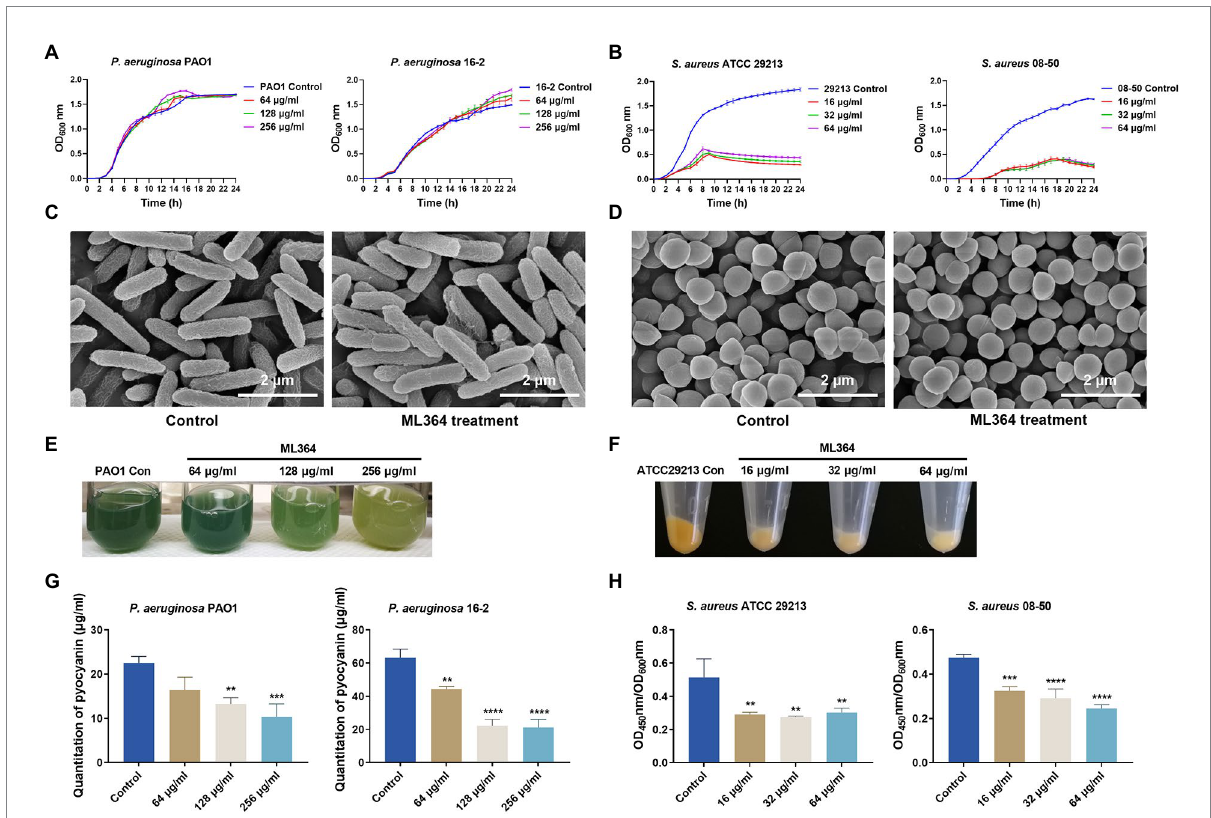
FIGURE 1 The in vitro studies of ML364. (A) Growth curves of Pseudomonas aeruginosa PAO1 and carbapenem-resistant P. aeruginosa (CRPA) 16-2 treated with and without ML364. (B) Growth curves of S. aureus ATCC 29213 and methicillin-resistant Staphylococcus aureus (MRSA) 08-50 treated with and without ML364. (C) Images from SEM for P. aeruginosa PAO1 treated with or without 256 μ g/ml ML364. (D) Images from SEM for S. aureus ATCC 29213 treated with or without 64 μ g/ml ML364. (E) Production of pyocyanin by P. aeruginosa PAO1 in the presence or absence of ML364. (F) Production of staphyloxanthin by S. aureus ATCC 29213 in the presence or absence of ML364. (G) Quantitation of pyocyanin in P. aeruginosa PAO1 and CRPA 16-2 treated with and without 64–256 μ g/ml ML364. (H) Quantitation of staphyloxanthin in S. aureus ATCC 29213 and MRSA 08- 50 treated with and without 16–64 μ g/ml ML364. Control represents the solvent treatment group. Data were calculated with one-way ANOVA and Bonferroni’s multiple comparisons, compared to those of the control group; * p < 0.05, ** p < 0.01, *** p < 0.001, **** p <